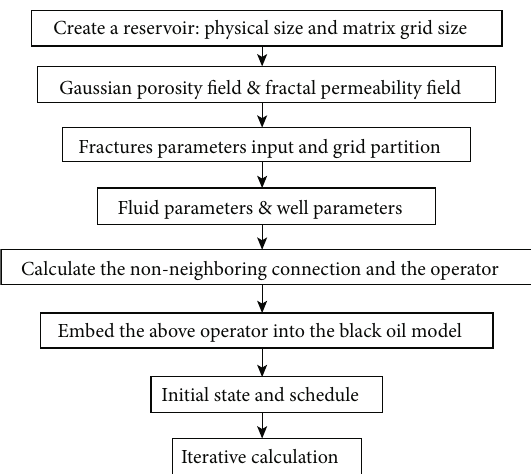
Figure 1: Microscopic characteristics of natural microfractures in tight reservoir. Figure 2: The schematic diagram of the calculation.